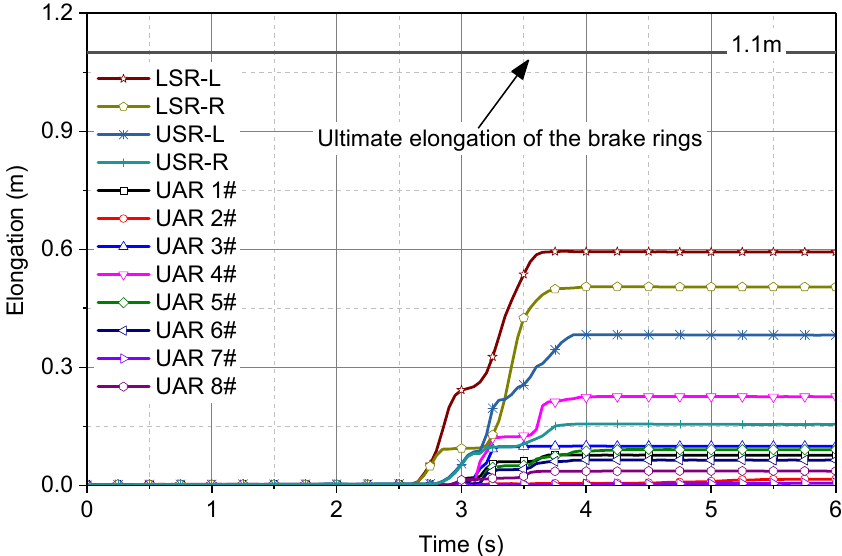
Figure 11. Elongations of brake rings in the numerical simulation. Table 3. Deflection of the flexible barrier and elongation of the brake rings. Components